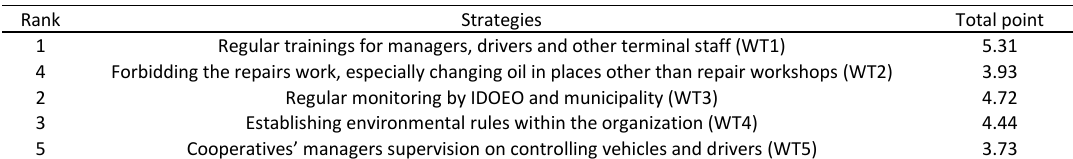
Table 10: Prioritizing the strategies